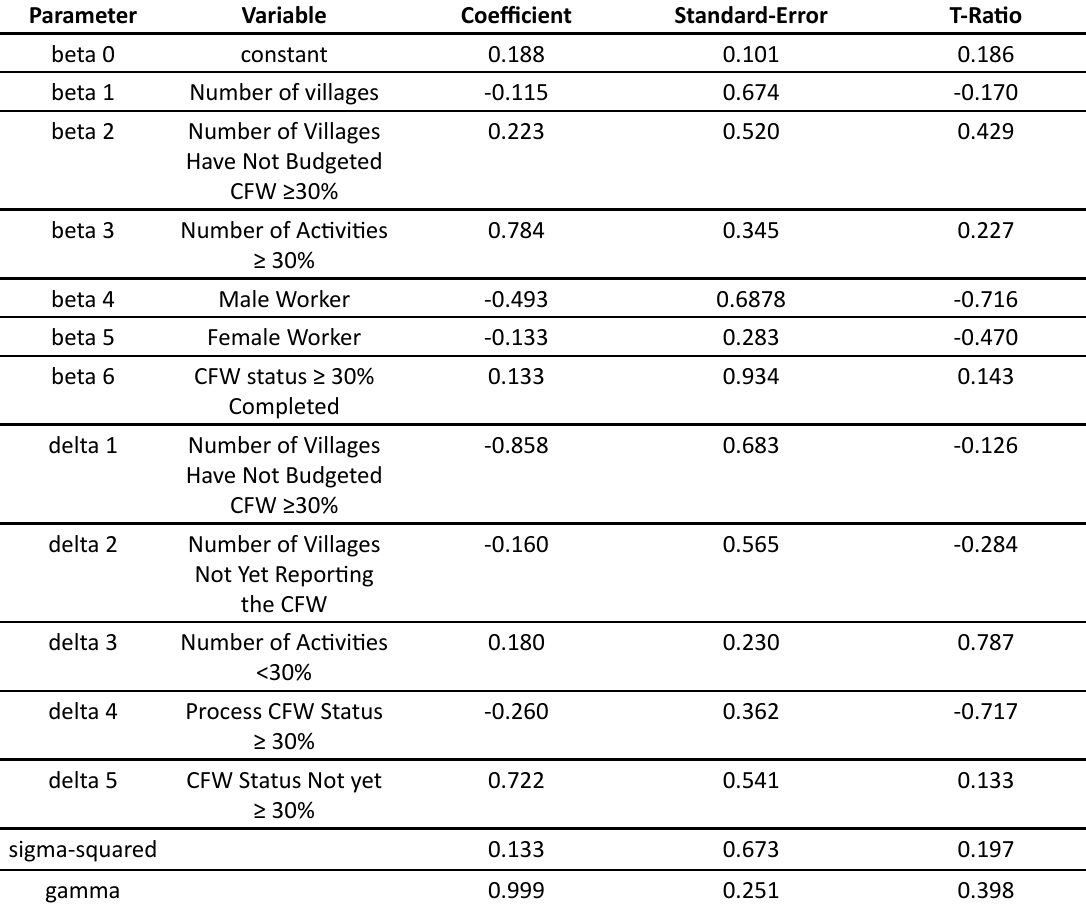
Table 2: Stochastic Frontier Production Function with TE Effects